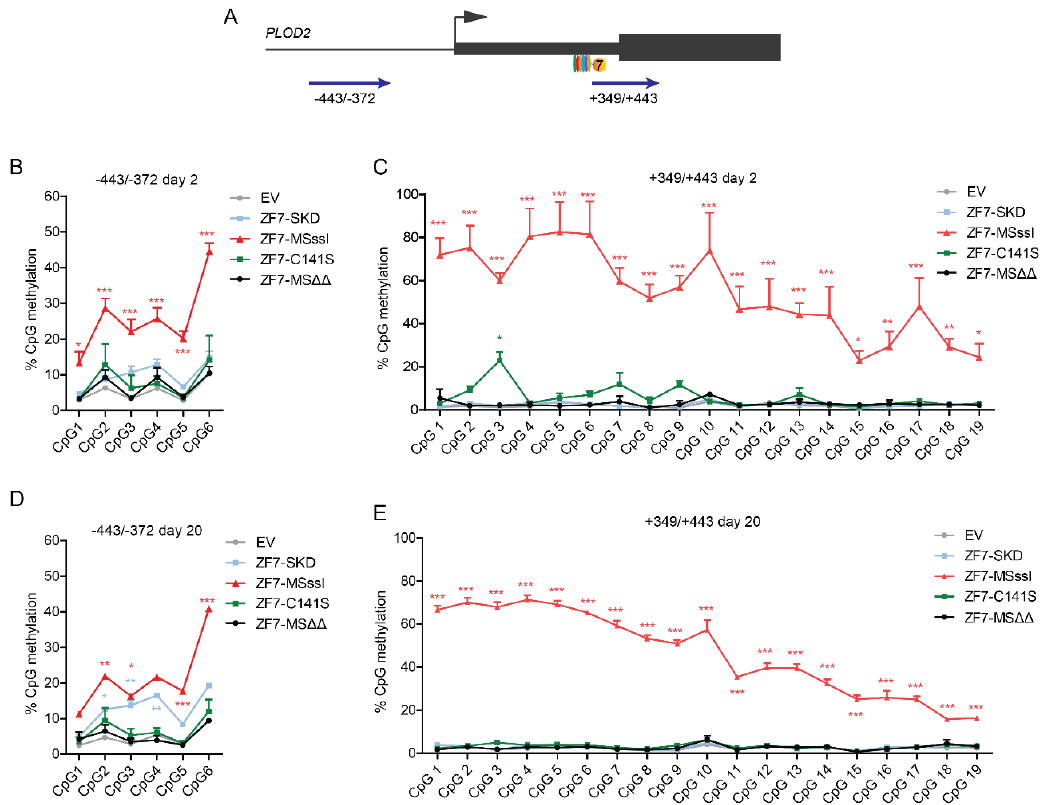
Figure 6. Targeting M.SssI induces strong and long-range DNA methylation in transgenic MDA-MB-231 cells. MDA-MB-231 cells, stably engineered to contain the indicated transgenes, were treated with doxycycline for 2 days and subcultured for an additional 2 and 20 days. ( A ) Schematic representation of the PLOD2 locus. The approximate locations of the ZF7 binding site, the transcriptional start size, and the two regions ( − 443 to − 372 and + 349 to + 443) analyzed for induced DNA methylation are indicated. ( B – E ) DNA CpG methylation levels quantified by pyrosequencing ( B ) region − 443 to − 372, two days after doxycycline withdrawal; ( C ) region + 349 to + 443, two days after doxycycline withdrawal; ( D ) region − 443 to − 372, 20 days after doxycycline withdrawal; ( E ) region + 349 to + 443, 20 days after doxycycline withdrawal. All pyrosequencing data are depicted as mean ± SEM; n = 3, two-way ANOVA * p < 0.05, ** p < 0.01, *** p < 0.001.